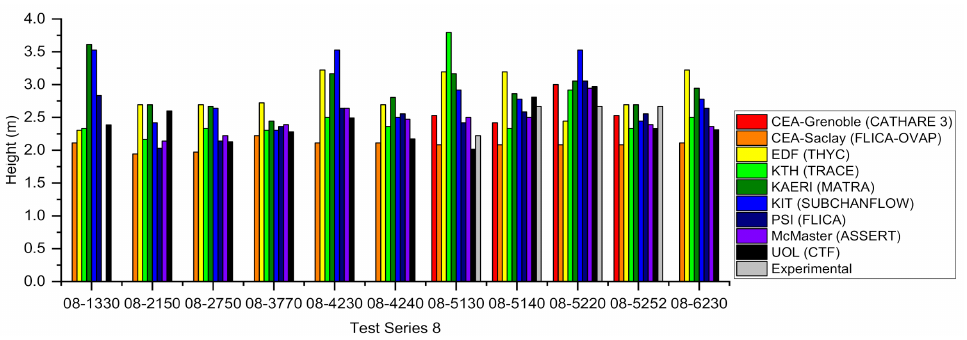
Figure 10. Codes departure from nucleate-boiling